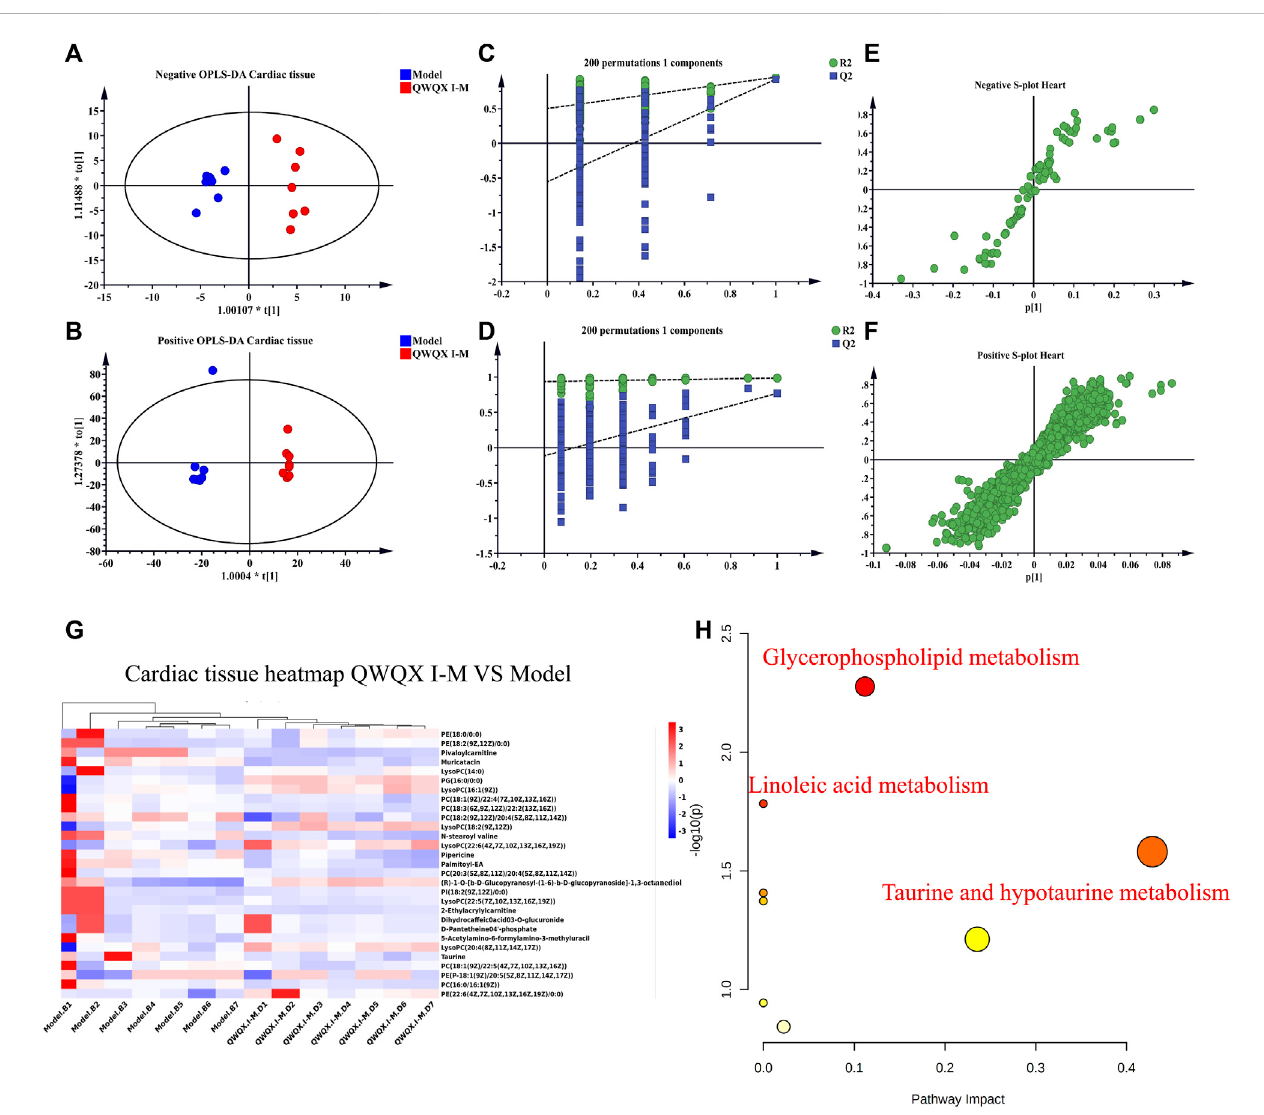
FIGURE 9 Multivariatestatisticalanalysis ofcardiactissueinQWQXIandmodelgroupsofrats. (A – B) PlotsofOPLS-DAscoresinQWQXIandmodelgroups. (C – D) Validation plots after 200 replacement tests. (E – F) S-plots of QWQX I and model groups in OPLS-DA model. (G) Heatmap of QWQX I against chronic heart failure in rats, (H) Plots of metabolic pathways associated with QWQX I against chronic heart failure in rats. (A, C, E) negative mode; (B, D, F) positive